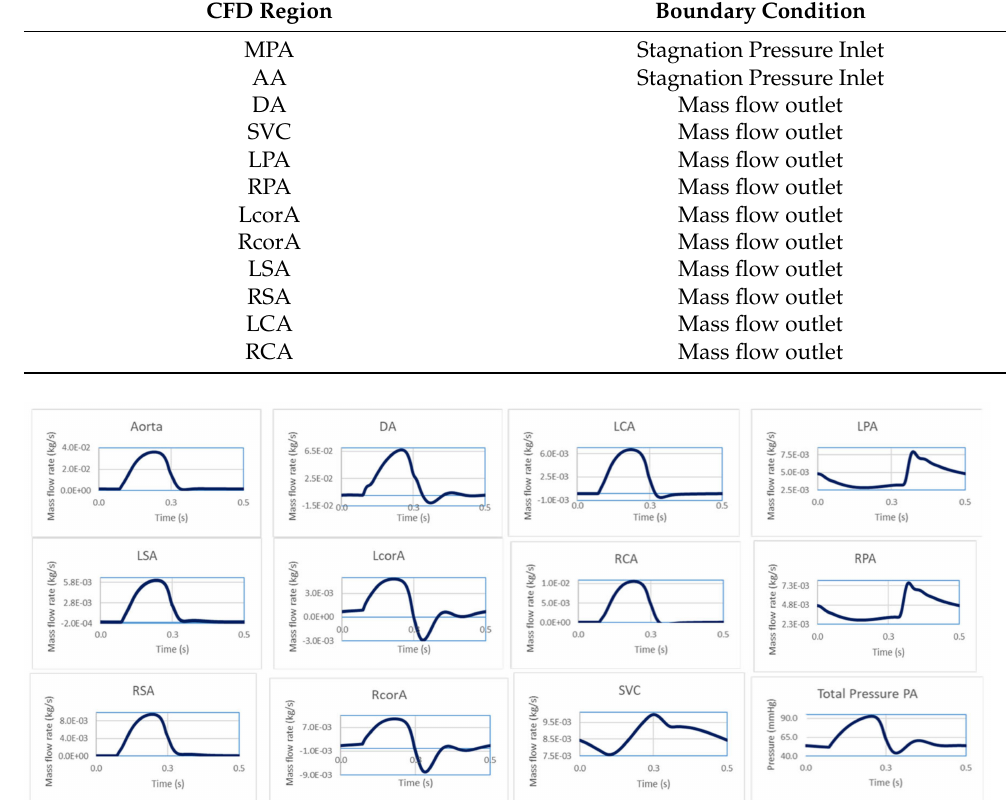
Figure 8. Sample BC waveforms for all inlets and outlets used in the CFD